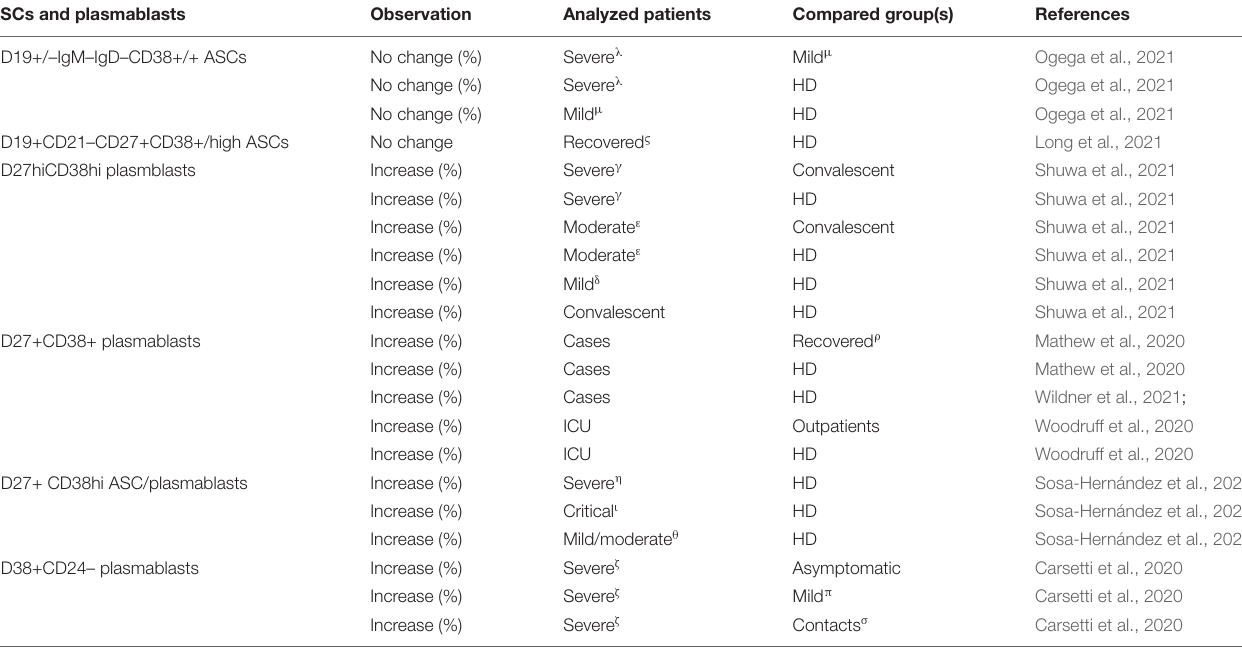
TABLE 8 | Observed fluctuation in ASCs and plasmablasts in adult COVID-19